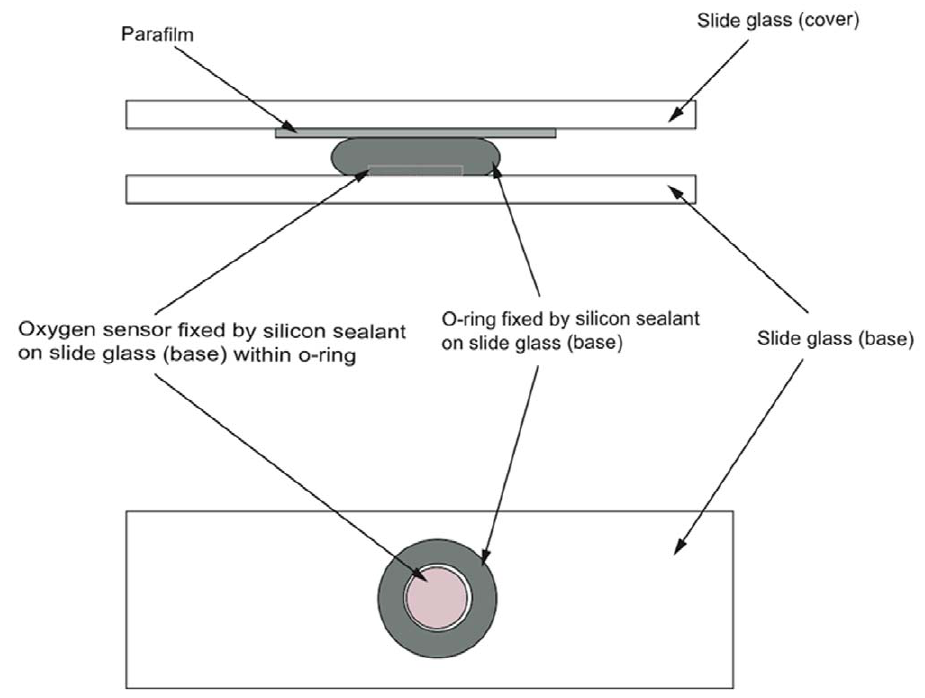
Figure 1. Chamber used for oxygen consumption measurements. Upper, lateral view; lower, upper view.